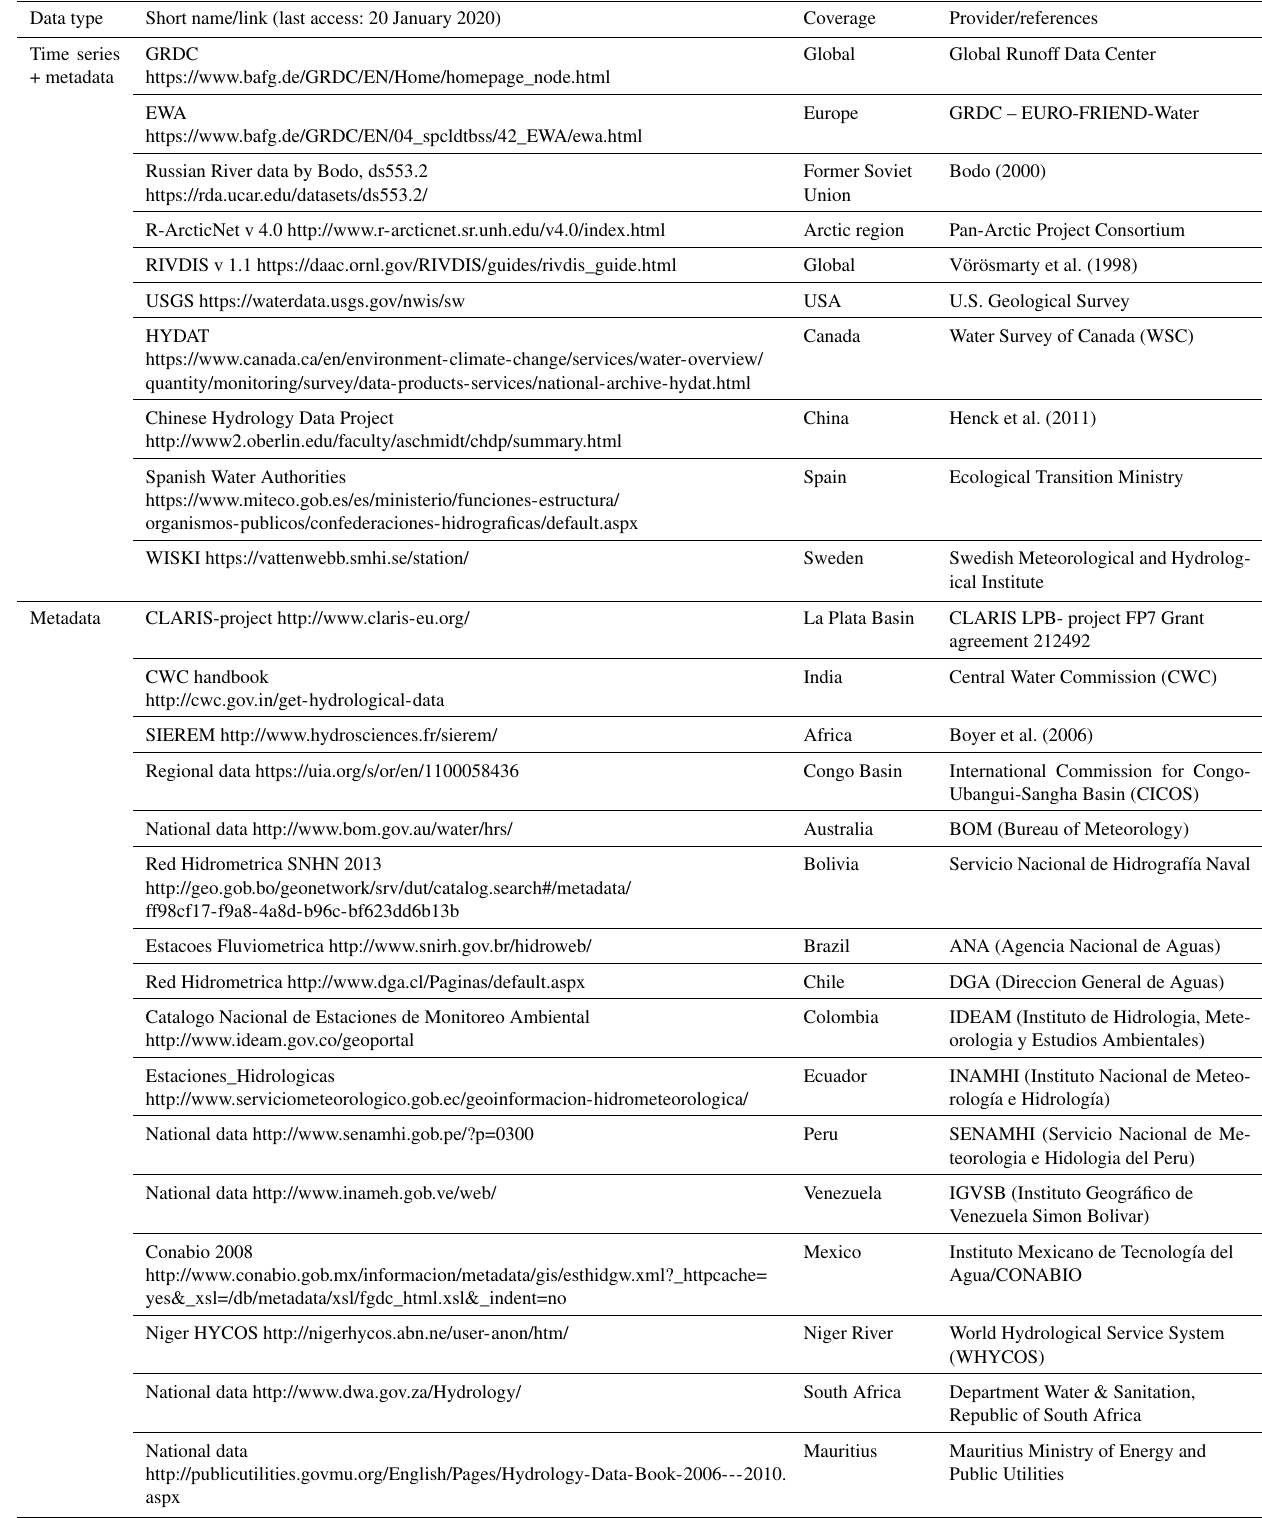
Table 3. Databases used for time series of water discharge and location of gauging station when estimating parameters and evaluating the model performance of WWH version